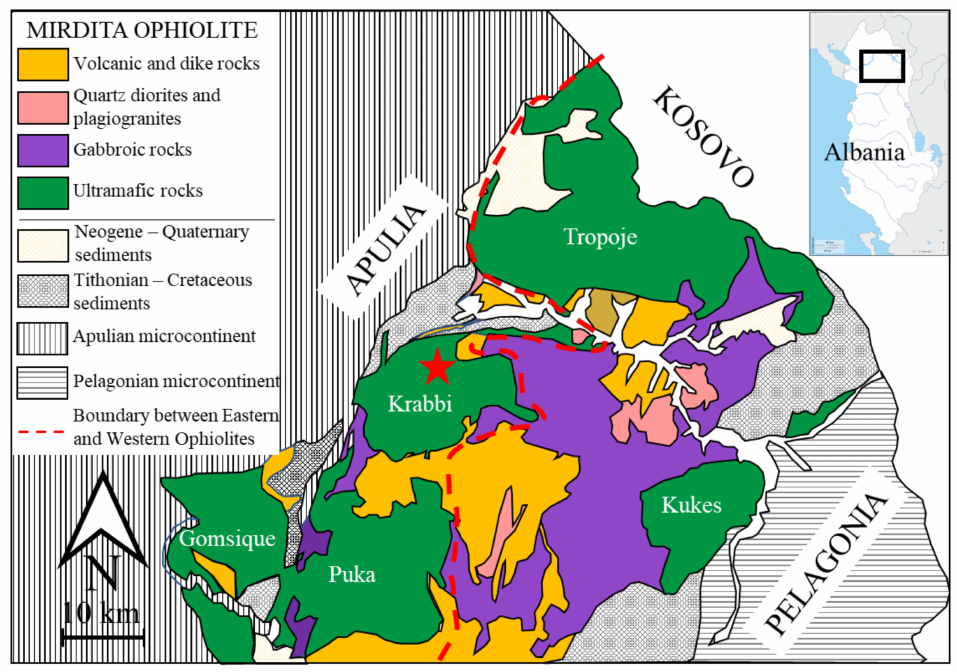
Figure 1. Simplified geological map of the Mirdita ophiolite (coloured). The red star represents the sampling location. Modified after Dilek et al.